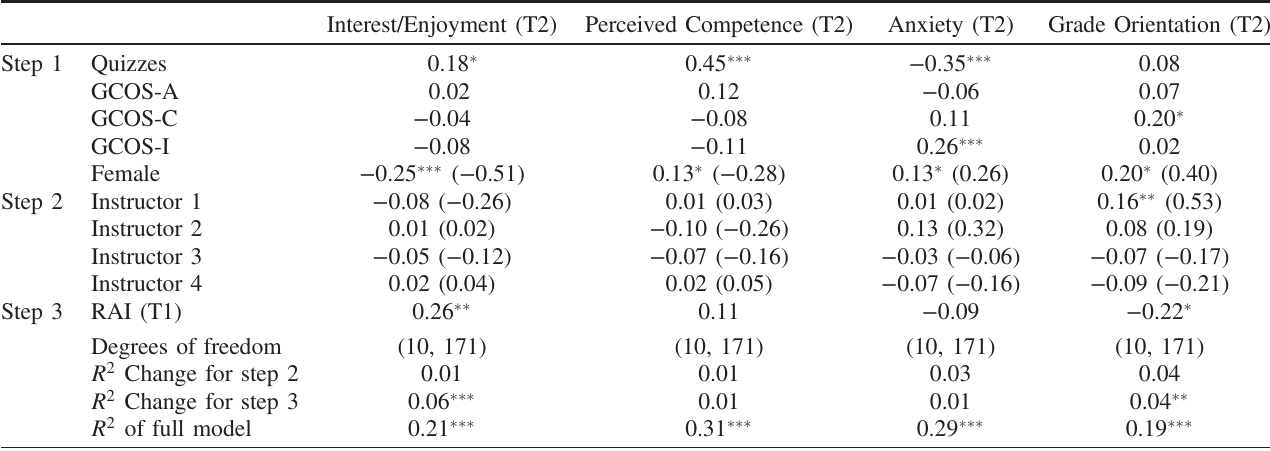
TABLE IV. Regressions of each dependent variable (Interest/Enjoyment, Perceived Competence, Anxiety, and Grade Orientation) at the end of the course (T2) onto control variables (steps 1 and 2) and initial relative autonomous reasons for studying physics [RAI (T1), step 3]. Standardized correlation coefficients ( β ’ s) are given with accompanying p values, where (cid:2) p < 0 . 05 , (cid:2)(cid:2) p < 0 . 01 , (cid:2)(cid:2)(cid:2) p < 0 . 001 . Given that fully standardized coefficients have little meaning for dummy variables, the coefficients when only the dependent variables ’ s) are given in parentheses for dummy independent variables (i.e., Female and the instructor variables). The were standardized ( β DV degrees of freedom, R 2 changes, and R 2 of the full model are also given for each model. We see that more autonomous reasons for studying physics when entering the course predicted significantly higher interest and enjoyment in learning physics and less of a focus on grades (versus learning) ( N ¼ 182